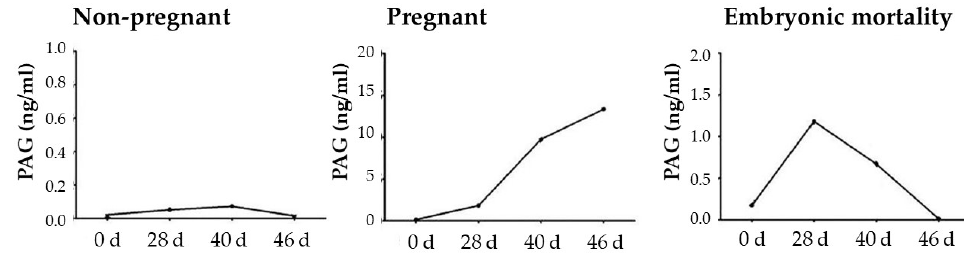
Figure 7. Pregnancy-associated glycoprotein (PAG) plasma concentrations in non-pregnant and pregnant buffalo cows, and those that experienced embryonic mortality. Adapted from Barbato et al. [119].